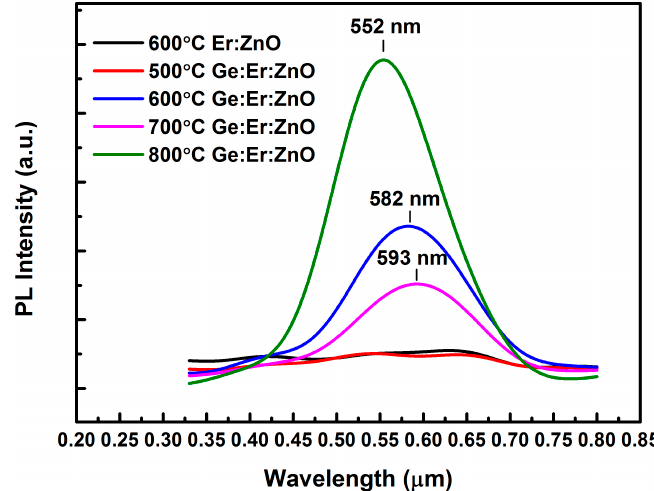
Figure 2. Visible photoluminescence (PL) spectra of the 600 °C annealed Er:ZnO film, and Ge:Er:ZnO films annealed at different temperatures.